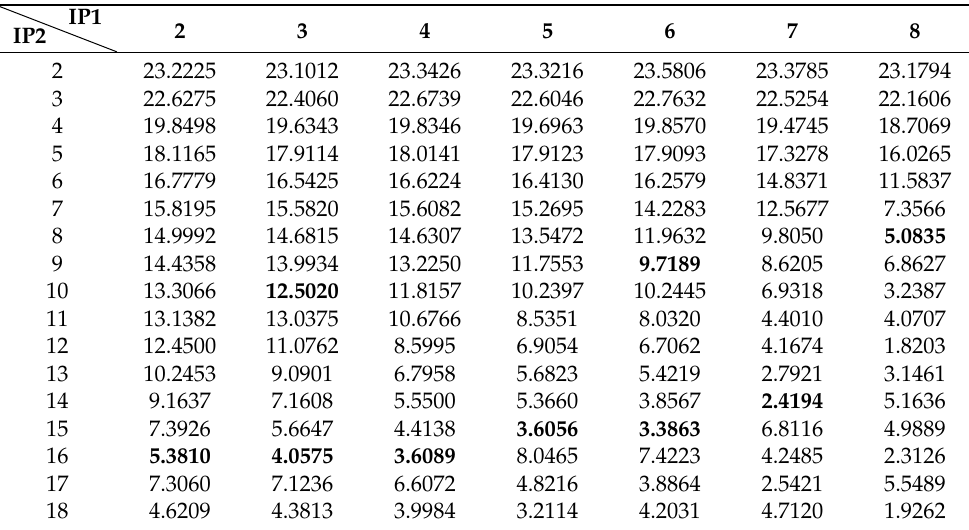
Table 3. The signal-to-noise ratio ( SNR ) with different numbers of IPs for the 8.85-year cycle at Boston. The IP1 and IP2 represent the numbers of IPs for the 18.61- and 8.85-year cycles of N 2